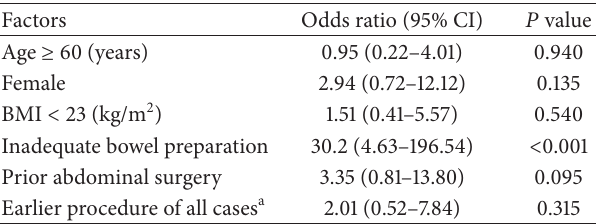
Table 4: Multivariate logistic regression analysis to determine predisposing factors for prolonged